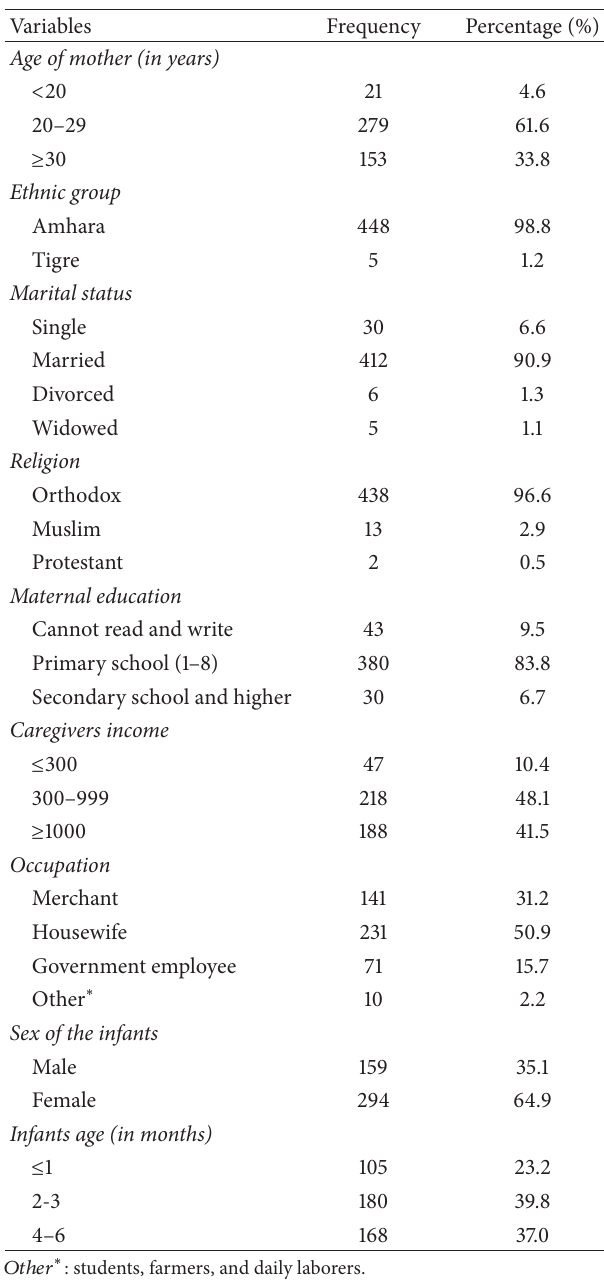
Table 1: Sociodemographic characteristics of the mothers with their infants( 𝑛 = 453 )amongmotherswhogavebirthinthelast6months in Debre Tabor town, Northwest Ethiopia,